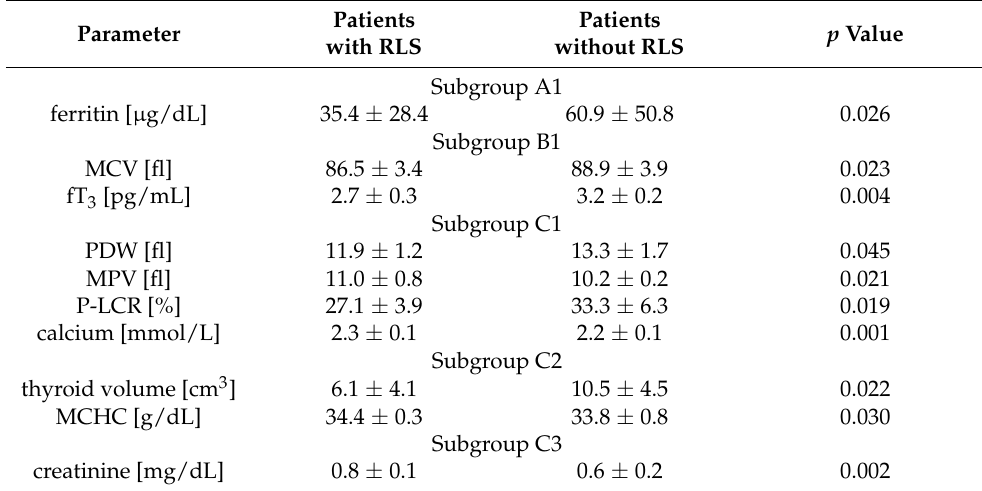
Table 5. Statistically significant differences between patients with and without RLS, distinguished into subgroups A1, B1, C1, C2 and